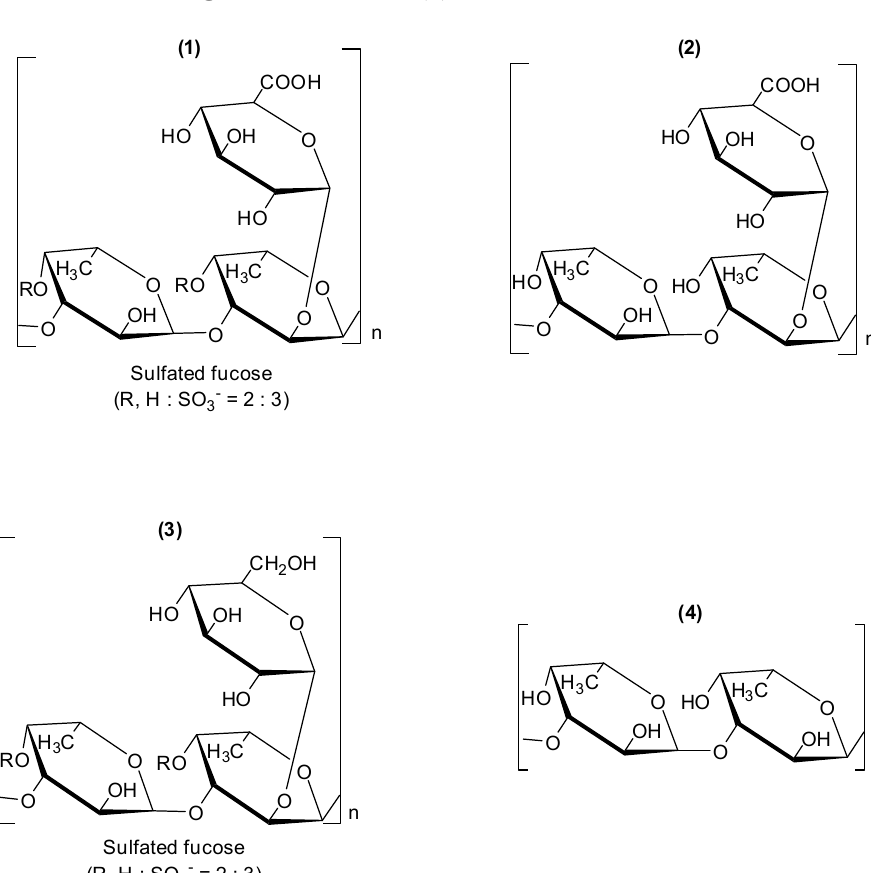
Figure 1. Fucoidan ( 1 ) and derivatives 2 – 4